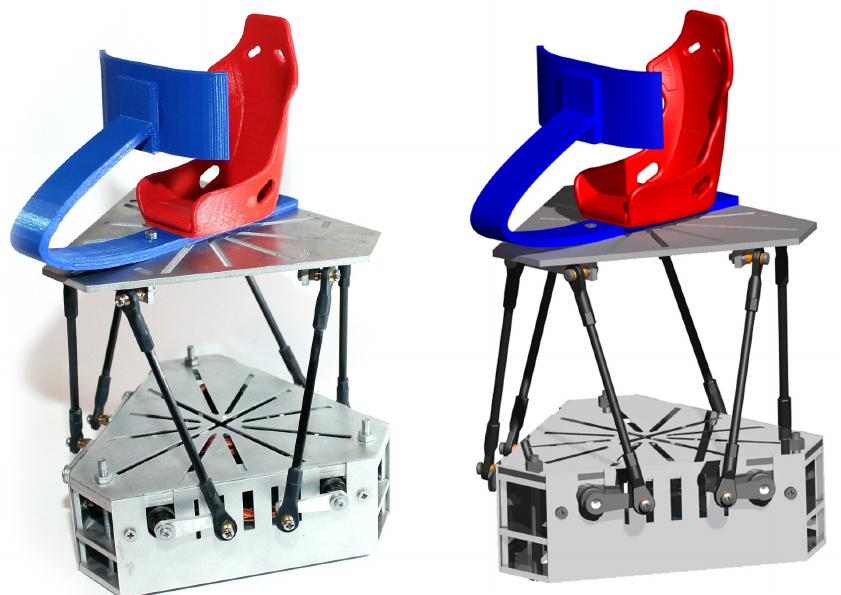
Figure 18. Scaled-down prototype of the mechanism (physical and 3D